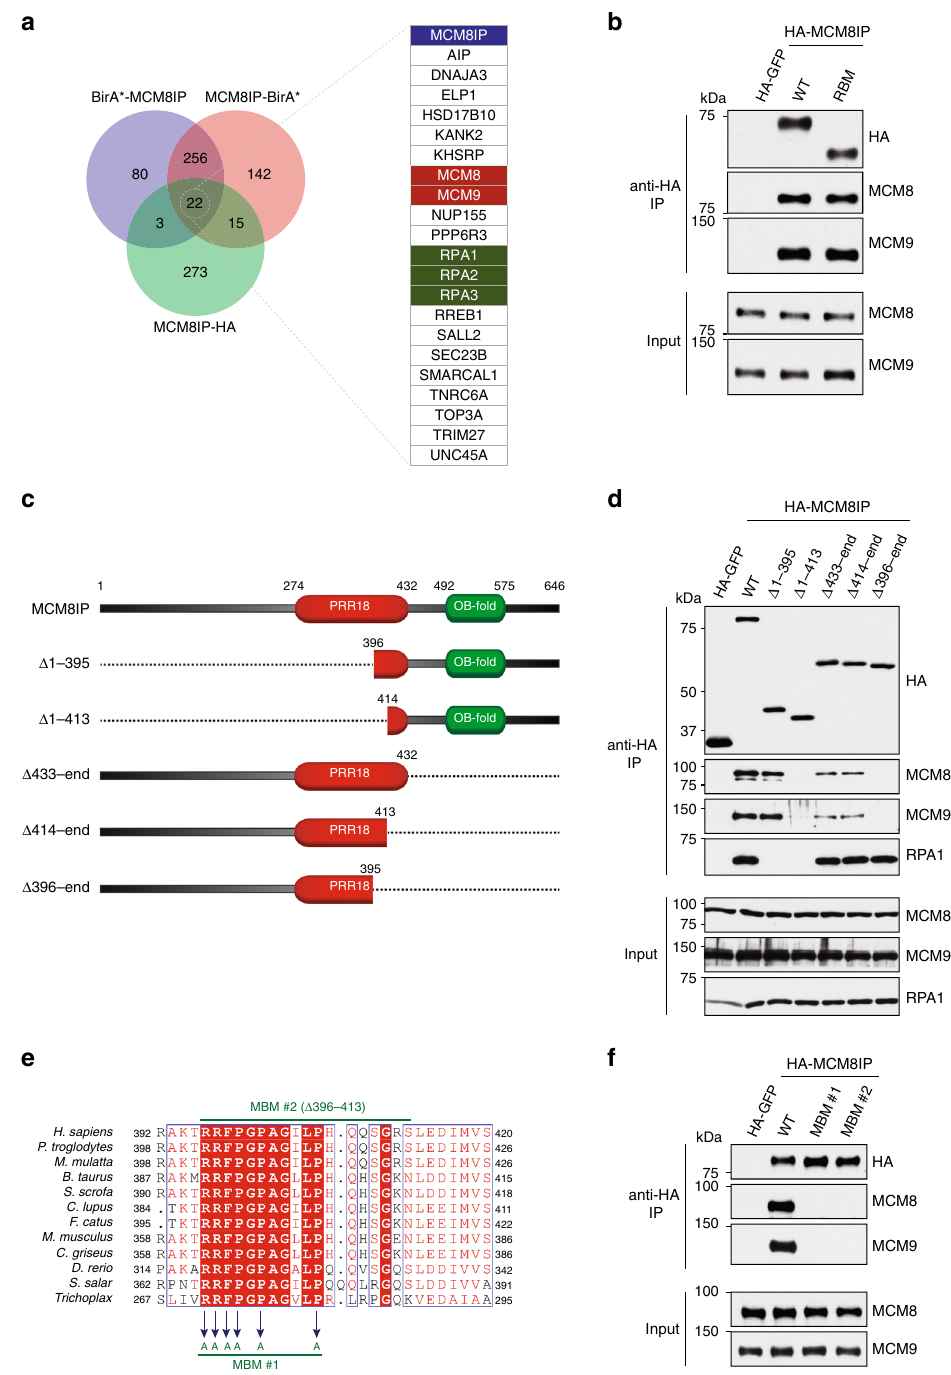
Fig. 3 Characterization of the interaction between MCM8IP and MCM8-9. a Venn diagram of the number of proteins identi fi ed by mass spectrometry that were enriched in BirA*-MCM8IP and MCM8IP-BirA* streptavidin pulldowns from HEK293T T-REx cells or MCM8IP-HA immunoprecipitates from HEK293T cells relative to their respective controls. Proteins with multiple enriched isoforms were considered a single hit in this diagram. A list of proteins commonly identi fi ed by all three experiments is presented. See also Supplementary Data 2. b Detection by western blot of MCM8 and MCM9 co- immunoprecipitated by HA-GFP, HA-MCM8IP WT, or RBM from HEK293T cells. c Schematic representation of MCM8IP truncation mutants used to identify the region of interaction with MCM8-9. d Detection by western blot of MCM8, MCM9, and RPA1 co-immunoprecipitated from HEK293T cells by HA-GFP, HA-MCM8IP WT, and mutants presented in ( c ). e Alignment from various species of the minimal region of human MCM8IP required for MCM8- 9 interaction. MCM8IP MBM #1 mutant carries alanine substitutions of the indicated residues. MCM8IP MBM #2 mutant carries a deletion of the indicated 18 amino acid residues. Sequence alignments were conducted using Clustal Omega and processed using ESPript. f Detection by western blot of MCM8 and MCM9 co-immunoprecipitated by HA-GFP, HA-MCM8IP WT, MBM #1 or MBM #2 from HEK293T